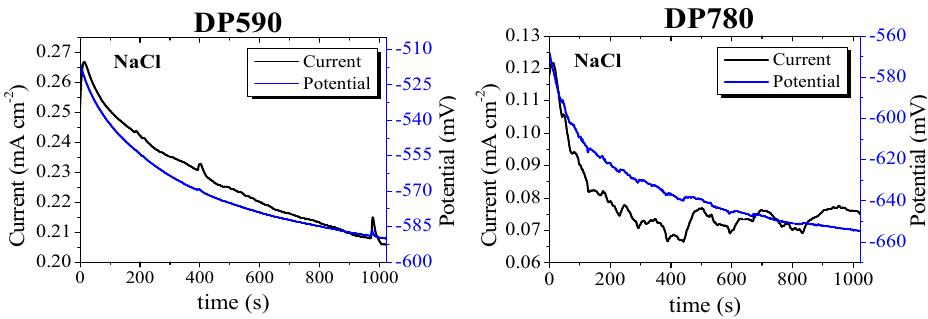
Figure 2. Direct current (DC) trend for time series electrochemical noise (EN) data of DP590 and DP780 steels immersed in NaCl solution.